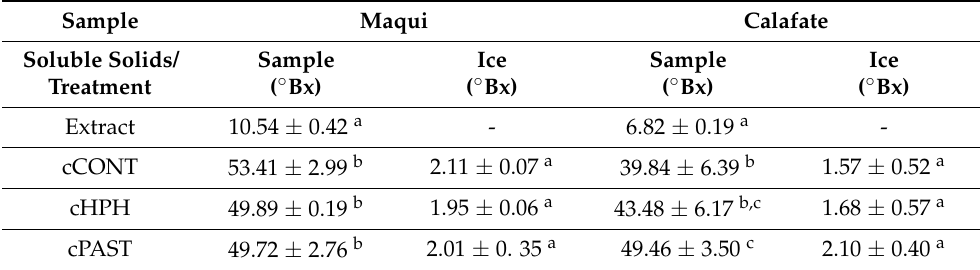
Table 2. Soluble solids content in maqui and calafate extracts and concentrates obtained by cryocon- centration after high-pressure homogenization, pasteurization, and an untreated control sample. Sample Maqui Calafate Soluble Solids/